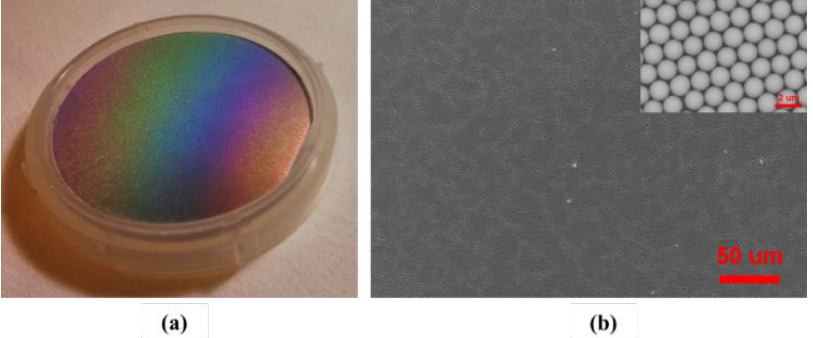
Figure 2. ( a ) Picture of silica sphere (SS) coated Si wafer (2-inch diameter) and ( b ) scanning electron microscope (SEM) images of SS coated Si surface.